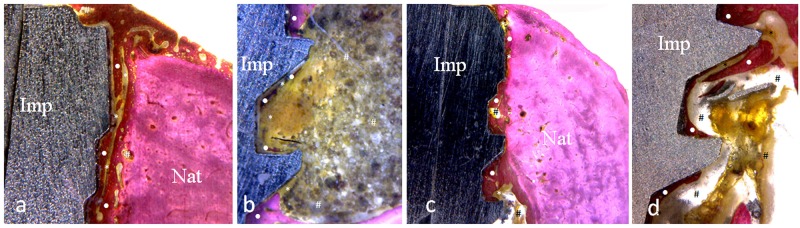
Representative images of the TEST group.(a) cortical portion with 3-weeks, (b) medullar portion with 3-weeks, (c) cortical portion with 4-weeks, (d) medullar portion with 4-weeks. Images obtained by light microscopy. New bone formed (●), osteoid matrix (*), medullary spaces (#), implant (Imp) and native bone (Nat).